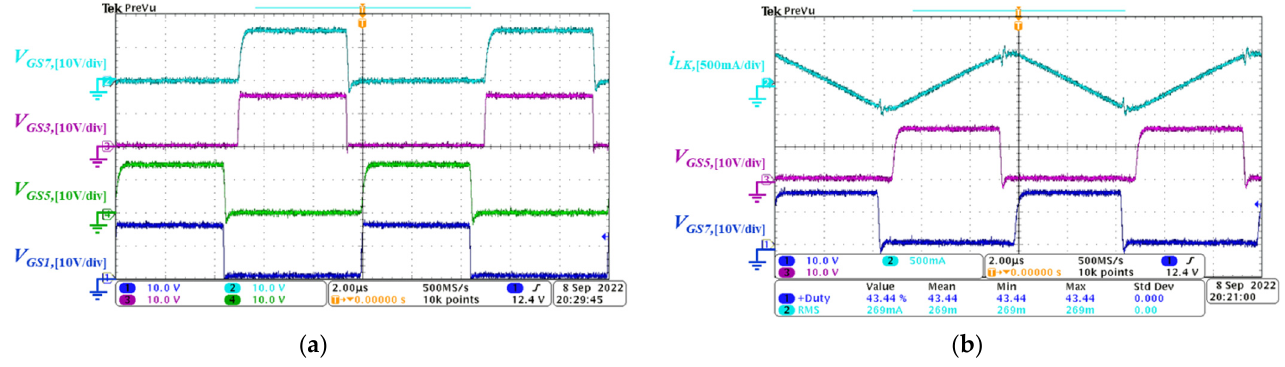
Figure 15. Experimental waveforms of the prototype converter operating in forward power conversion mode (at 1 kW output power): ( a ) waveforms of gate signals V GS1 , V GS3 , V GS5 and V GS7 ; ( b ) waveforms of gate signals V GS1 , V GS3 and inductor current i LK .